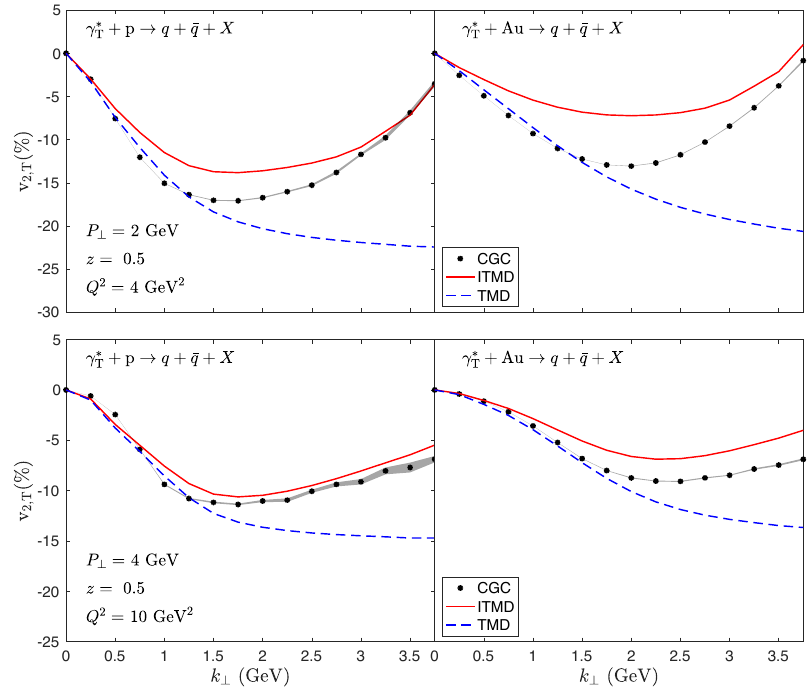
Figure 9 . Elliptic anisotropy v 2 in the angle φ for production of quark anti-quark pairs in γ ∗ (left) and γ ∗ + Au (right) scattering. The grey band shows the numerical uncertainty of the T CGC